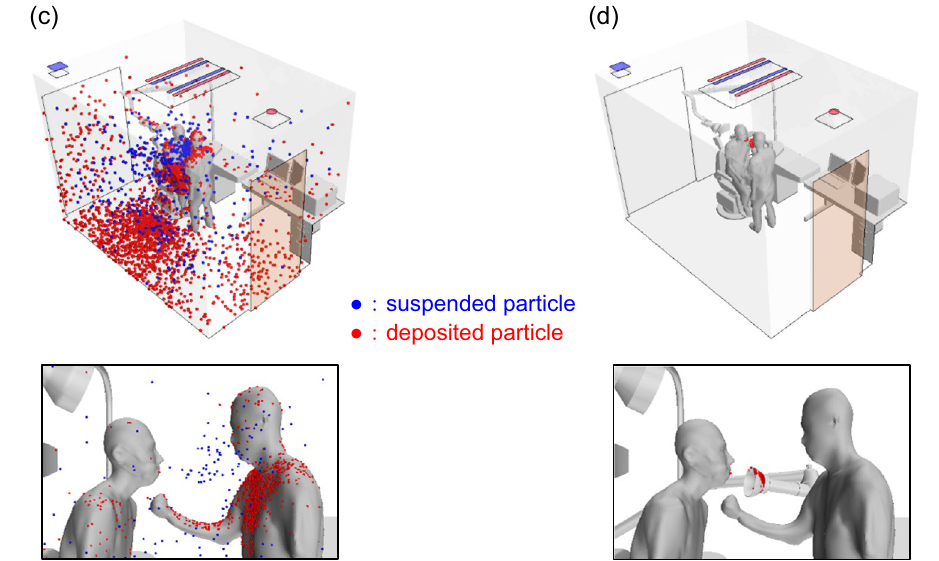
Figure 1. Simulation of suspended (blue) and deposited (red) particle distributions 100 s after the patient begins exhaling at a constant rate of 2.5 m/s (Case X) and assuming no evaporation, in the presence and absence of a suction device positioned as shown in Fig. 2. ( a ) Without suction device; average particle diameter, 10 μm. ( b ) With suction device; average particle diameter, 10 μm. ( c ) Without suction device; average particle diameter, 80 μm. ( d ) With suction device; average particle diameter, 80